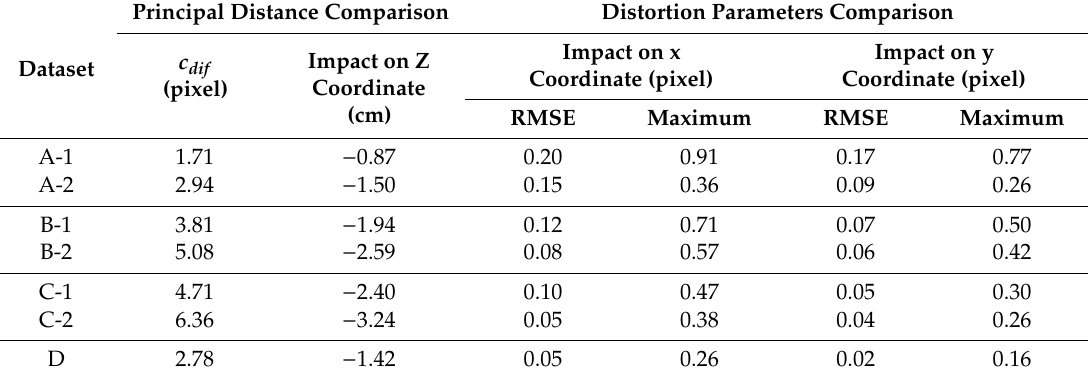
Table11. ConsistencybetweenrefinedIOPsderivedfromdi ff erentinitialcameraparameters: di ff erences between principal distances along with their impact on Z coordinates as well as RMSE and maximum of di ff erences between distortion-free grid vertices for the seven